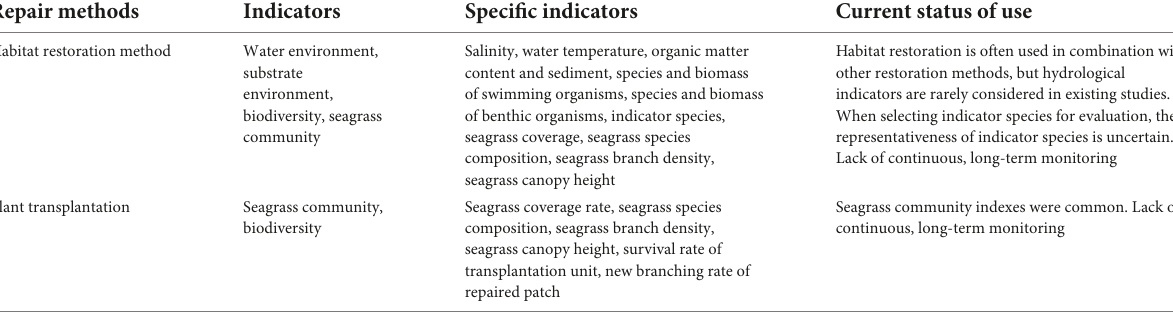
TABLE 1 Evaluation indexes of common seagrass bed ecological restoration effectiveness.